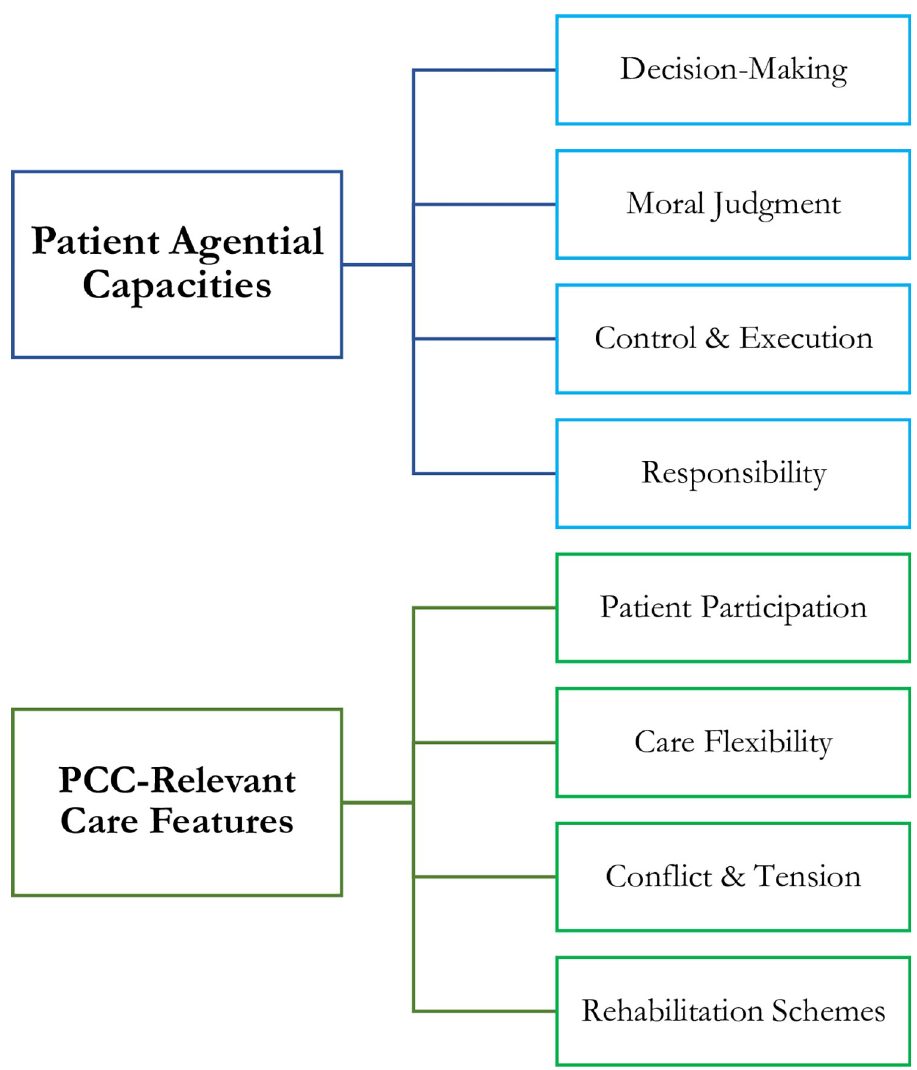
Fig 1. A tree diagram representing the categories of the analytic